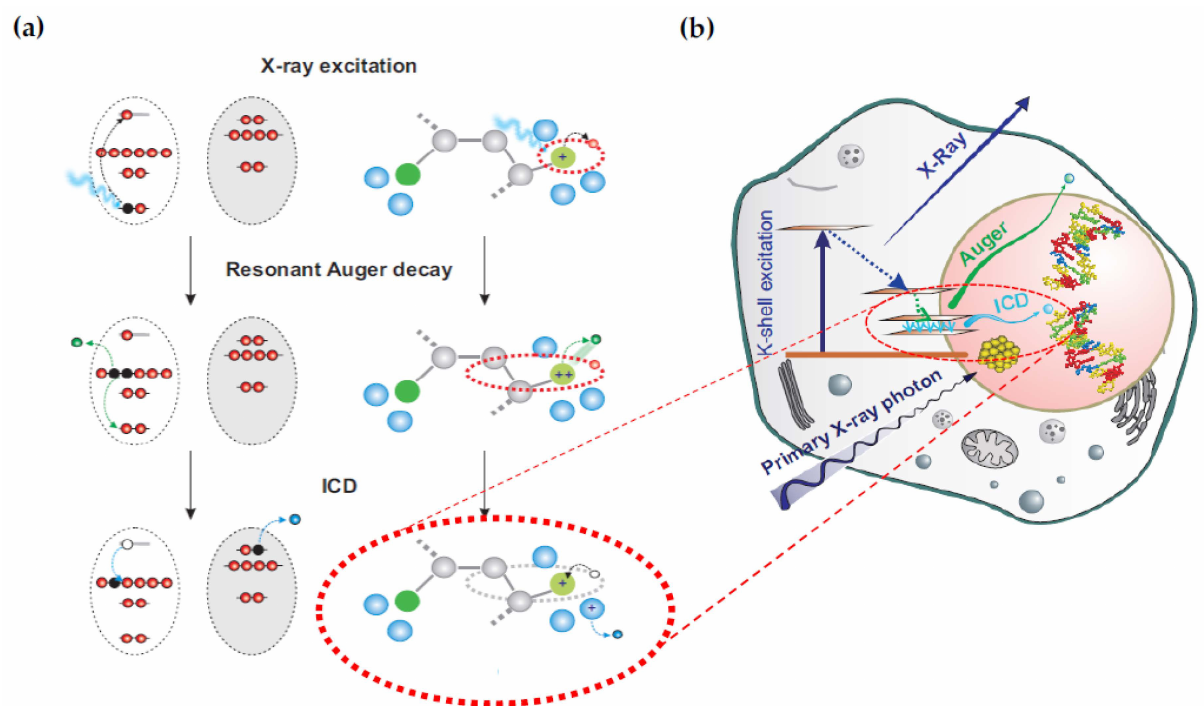
Figure 5. ( a ) A diagram of the resonant Auger decay process following X-ray excitation. The process known as interatomic or intermolecular Coulomb decay (ICD) can also occur leading to the ejection of slow electrons and adjacent holes. ( b ) Potential exploitation of Au nanoparticles and ICD in inducing controlled radiation damage of cells. (Adapted from [33] with